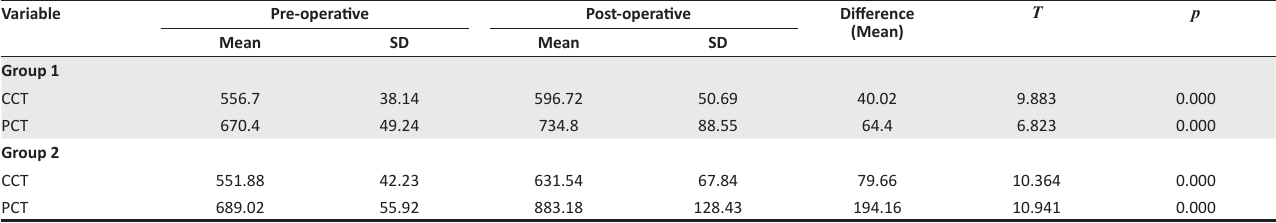
TABLE 6: Comparison of preoperative with post-operative central and peripheral corneal thickness between Group 1 (number = 50) and Group 2 (number = 50).